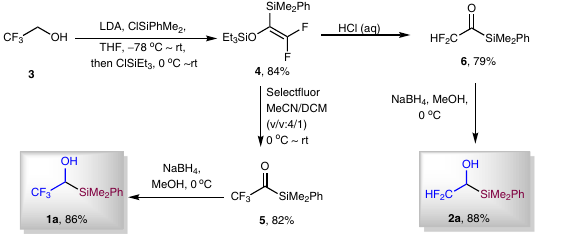
Fig. 2 Preparation of fl uoroalkyl group transfer reagents 1a and 2a.